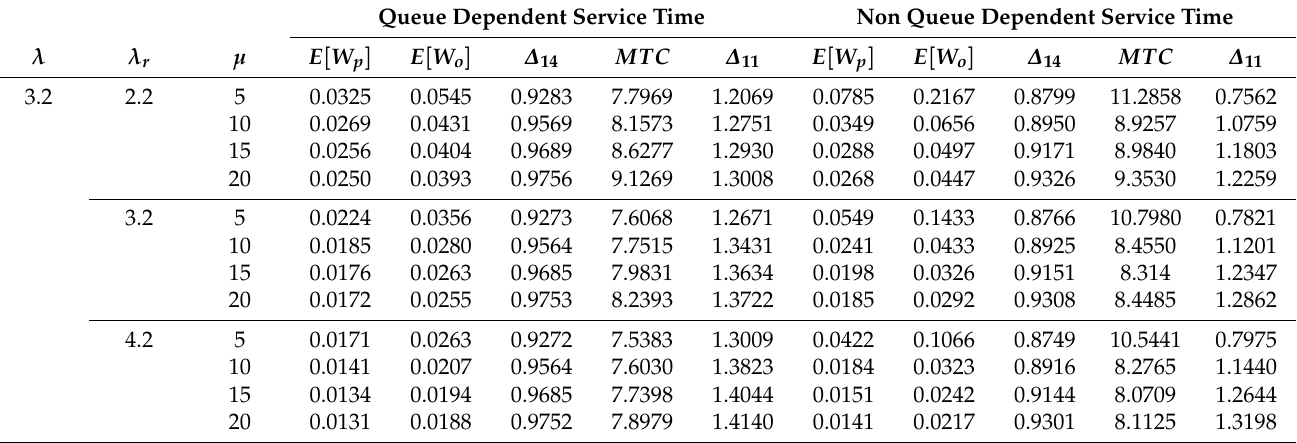
Table 3. Queue dependent service time Vs Non queue dependent service